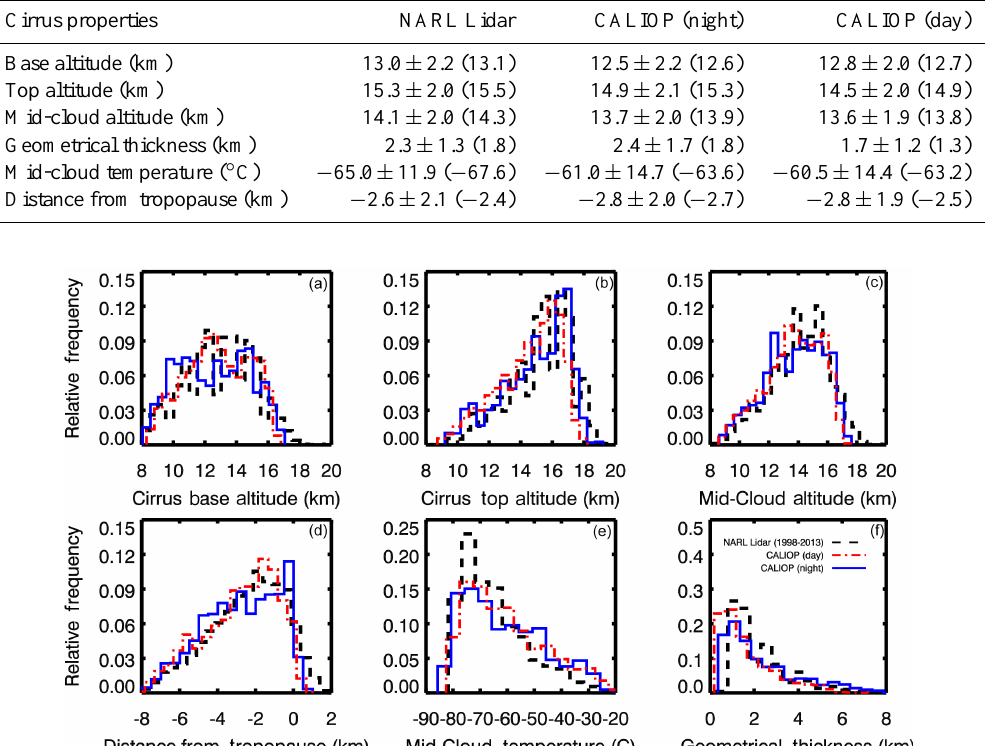
Figure 4. Histograms showing the frequency distribution of macrophysical properties of cirrus clouds viz. (a) base altitude, (b) top altitude, (c) mid-cloud altitude, (d) distance from the tropopause, (e) mid-cloud temperature, (f) geometrical thickness obtained from NARL Lidar (1998–2013) data (dashed black line), CALIOP daytime (single dot-dash red line) and CALIOP night-time (solid blue line) data sets. Bin size for (a) – (d) and (f) is 0.5km while bin size for (e) is 5 ◦